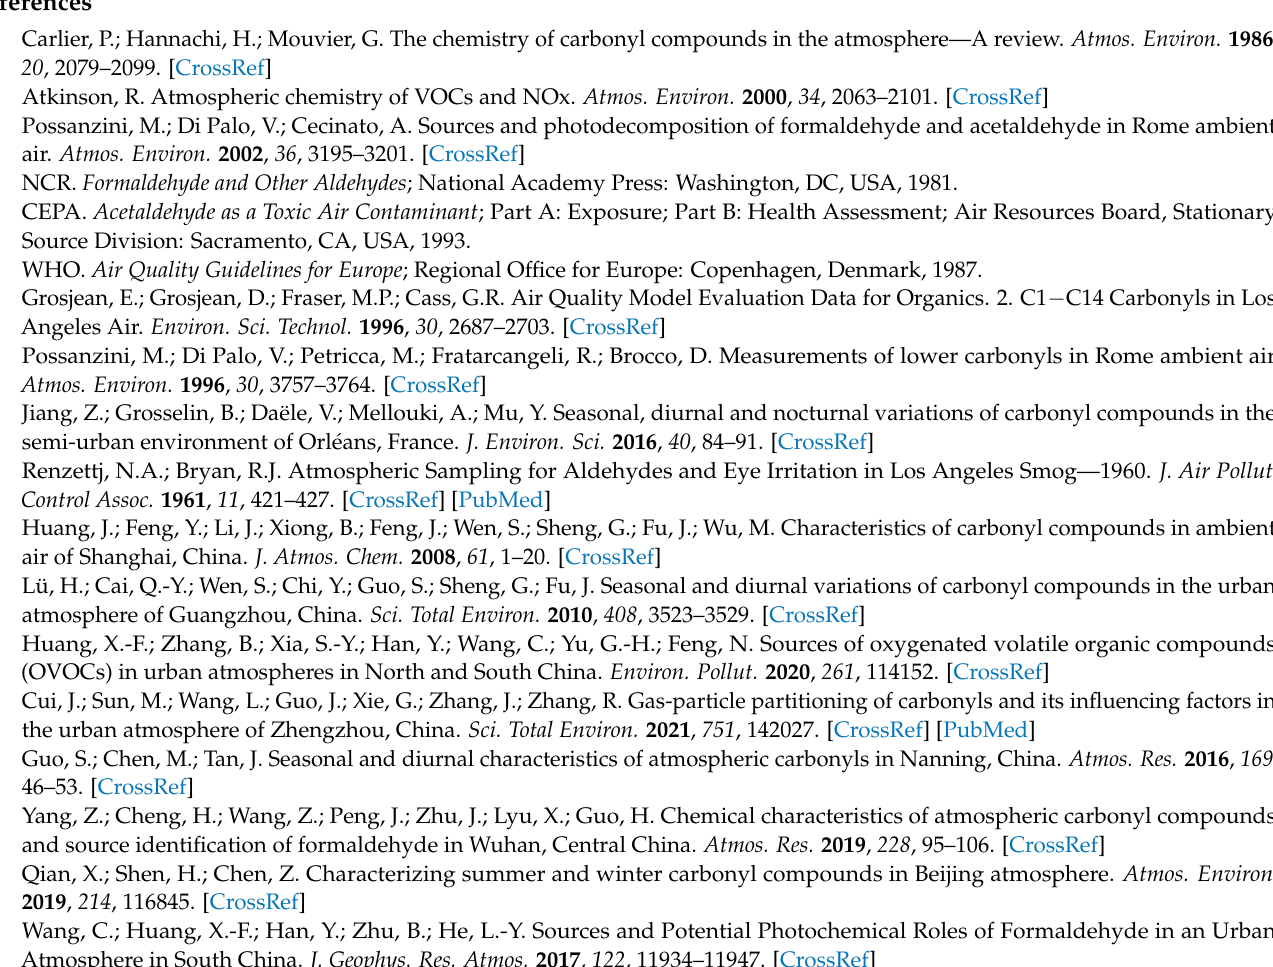
Figure A3. The wind direction weighted carbonyls concentrations in summer.